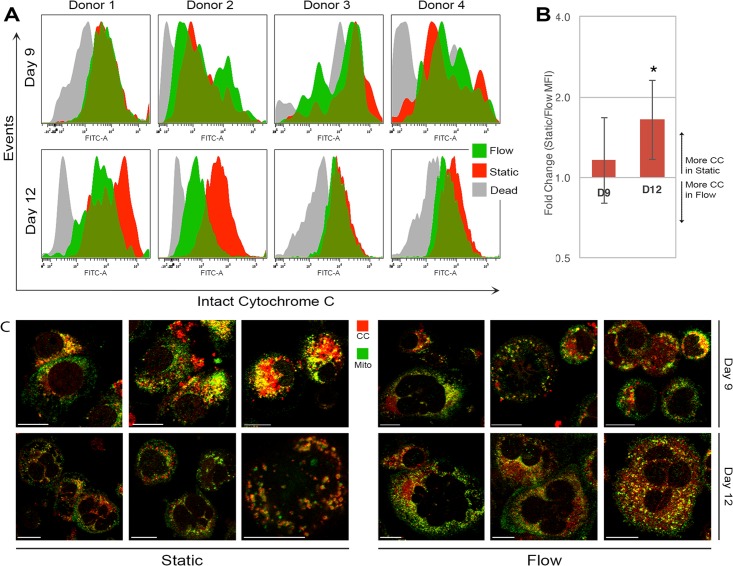
Mitochondria from immature and mature Mks subjected to shear flow have different levels of intact cytochrome c.A, Histograms showing cytochrome c expression in live static Mks (red), live Mks following shear flow (green), and dead Mks (gray). A peak shift to the left demonstrates decreased cytochrome c in the mitochondria membrane. B, Average fold change (static/flow) of mean fluorescence intensity of the histograms shown in A for day 9 (left) and day 12 (right). *p < 0.05, one-sample t-test, n = 4 (biological replicates), error bars: SD. C, Immunofluorescence confocal microscopy of d9 (top) and d12 (bottom) Mks probing for cytochrome c (red) and mitochondria (green); colocalization of the two appear as yellow (yellow). Scale bar: 10μm.